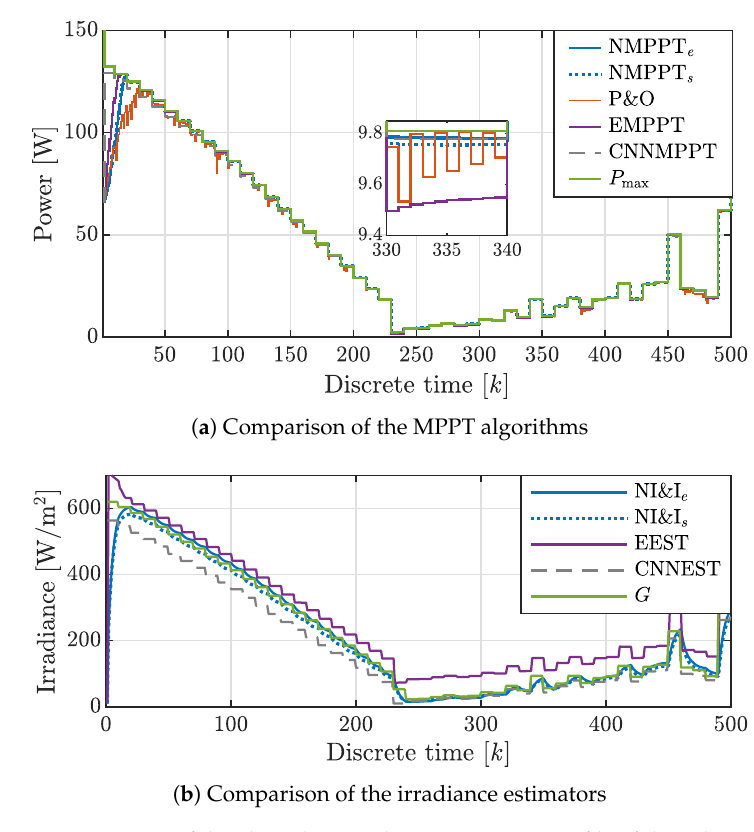
Figure 13. Comparison of the algorithms under time varying profile of the solar